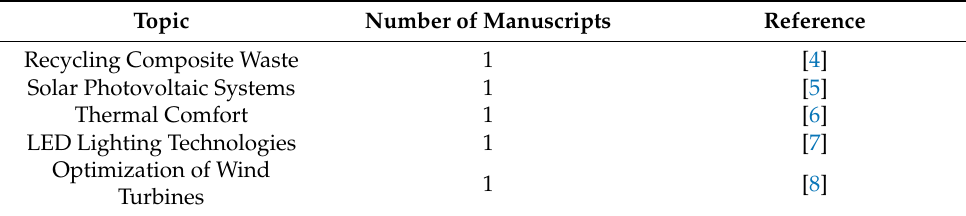
Table 3. Topics of the Sustainable